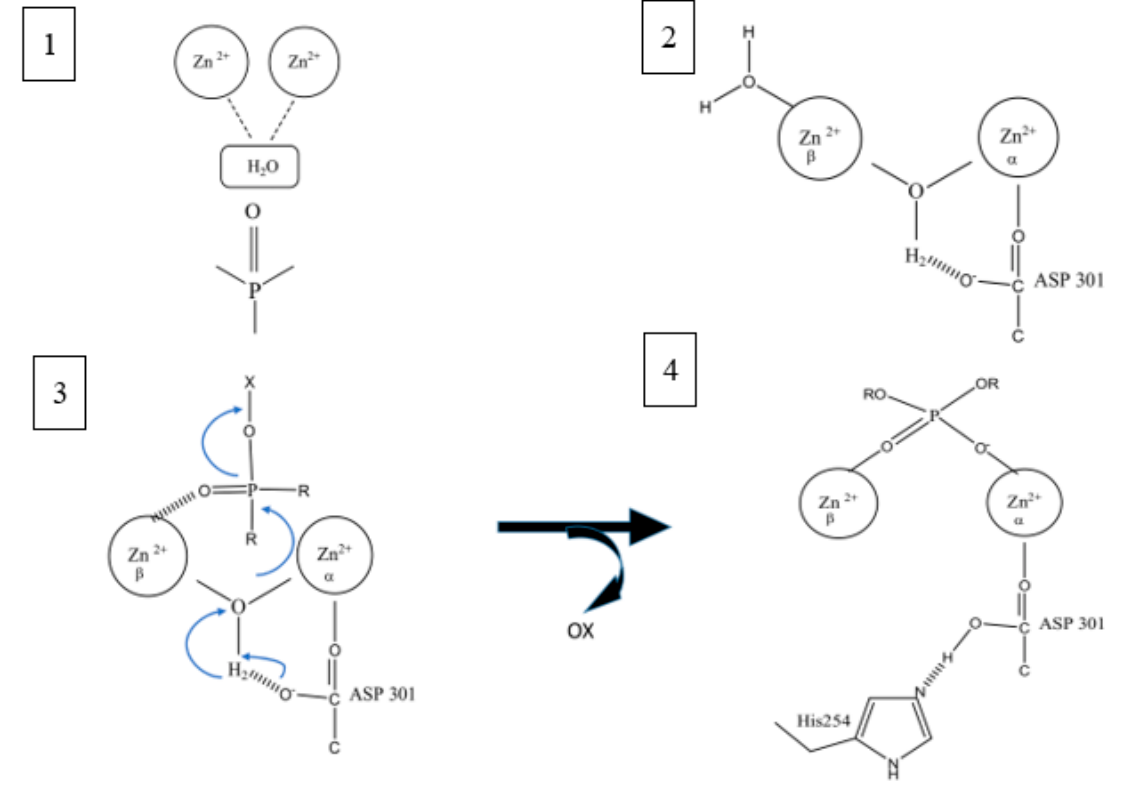
Figure 3. Proposed mechanism of PTE hydrolysis. 1: Three components for nucleophilic attack; 2: Active site of PTE without the substrate; 3: Mechanism hydrolysis of OP compound; 4: Proton transfer by Asp301.